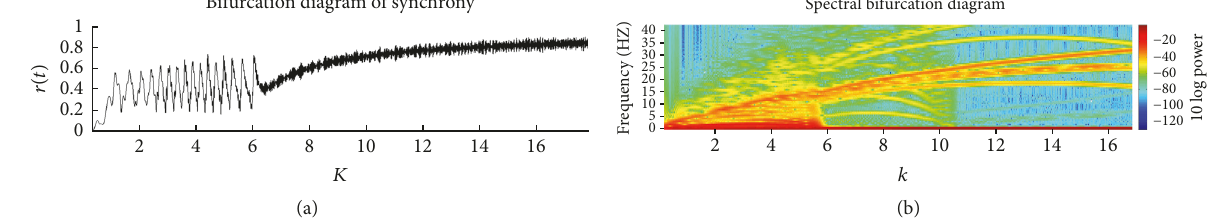
Figure 3: Bifurcation diagrams constructed to explore the evolution of synchrony in time, while 𝑘 is increased ( 𝑘 𝑡 = 𝑘 𝑡+1 + 5 × 10 −4 for 𝑡 in ms). As can be seen in the plot (a), metastability is abruptly reduced for 𝑘 ≈ 6.5. In the plot (b), we show the power spectra of synchrony. Slow components are reduced after the bifurcation in 𝑘 ≈ 6.5. An additional reduction in the components was found about 𝑘 ≈ 11. Note that although the frequency of oscillators is 60Hz, the behavior of 𝑟(𝑡) exhibits multiple